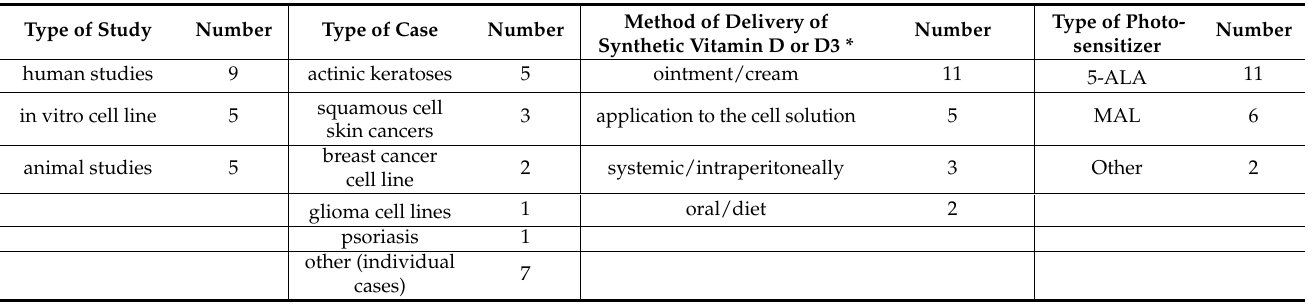
Table 2. Summary of studies